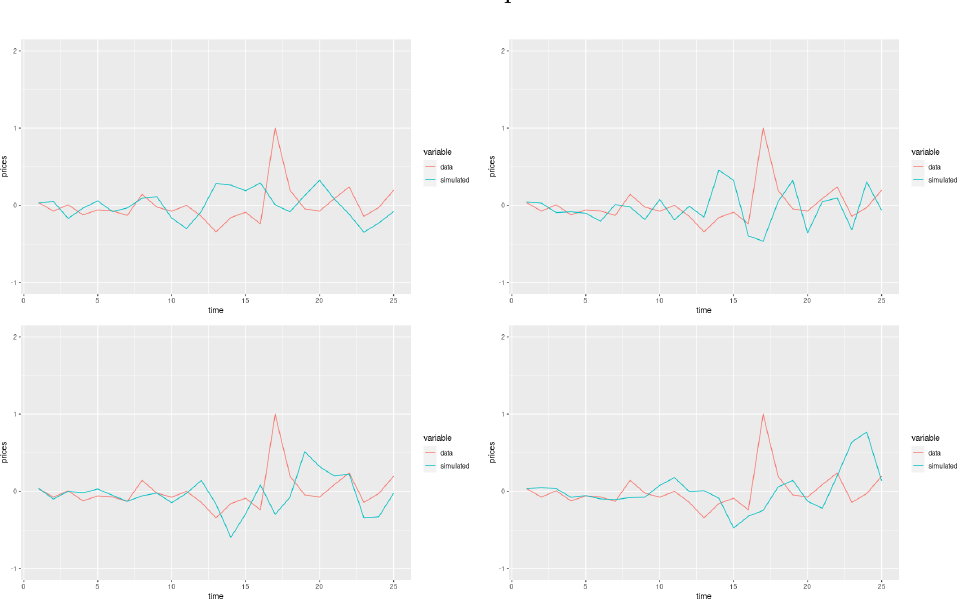
Figure A1. Price trajectories generated by the model (54) vs. the option prices on copper futures. Temporal range: from 1 February 2021 to 25 February 2022. Strikes (near the money): 340 call ( top left ), 340 put ( top right ), 345 call ( bottom left ), and 345 put ( bottom right